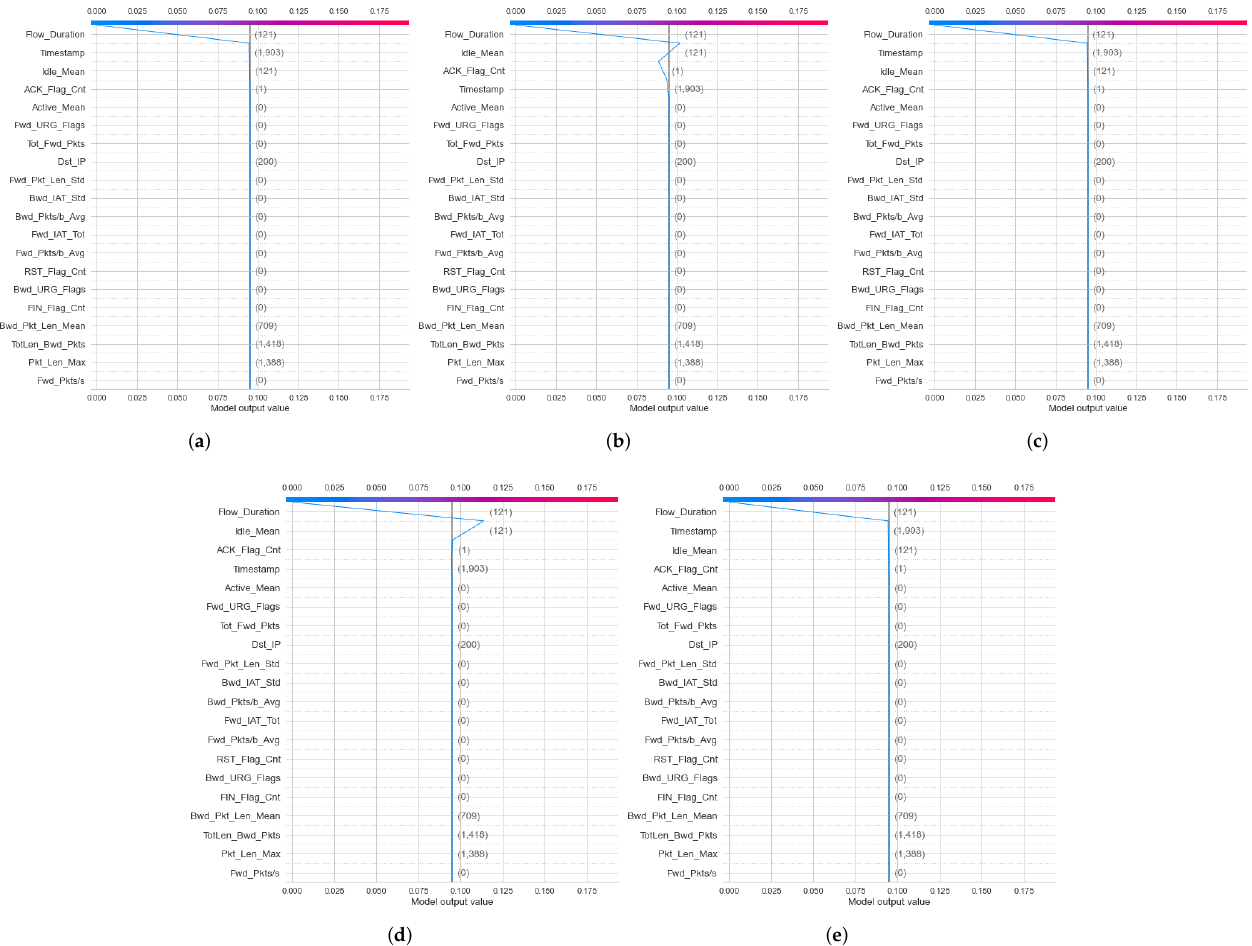
Figure 14. Decision plot results of local explanation for IoTID20 dataset in five Cat output values: ( a ) 0—MITM ARP Spoofing; ( b ) 1—Scan; ( c ) 2—DoS; ( d ) 3—Mirai; ( e )